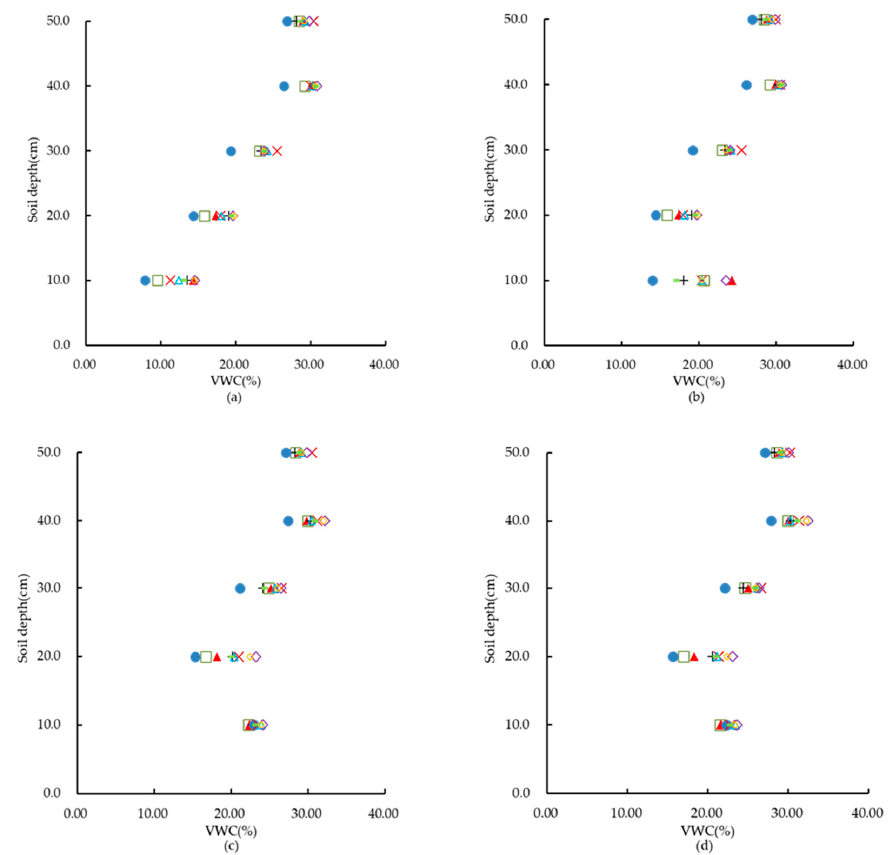
Figure 4. Volumetric water content (VWC) before irrigation, at the time of stopping irrigation, and 12 h and 24 h after sprinkler irrigation with different treatments, T1( □ ), T2( ▲ ), T3(+), T4( ● ), T5(×), T6( △ ), T7( ◇ ), T8( ○ ), and T9( ▬ ): ( a ) before irrigation; ( b ) at the time of stopping irrigation; ( c ) 12 h after irrigation; ( d ) 24 h after irrigation.